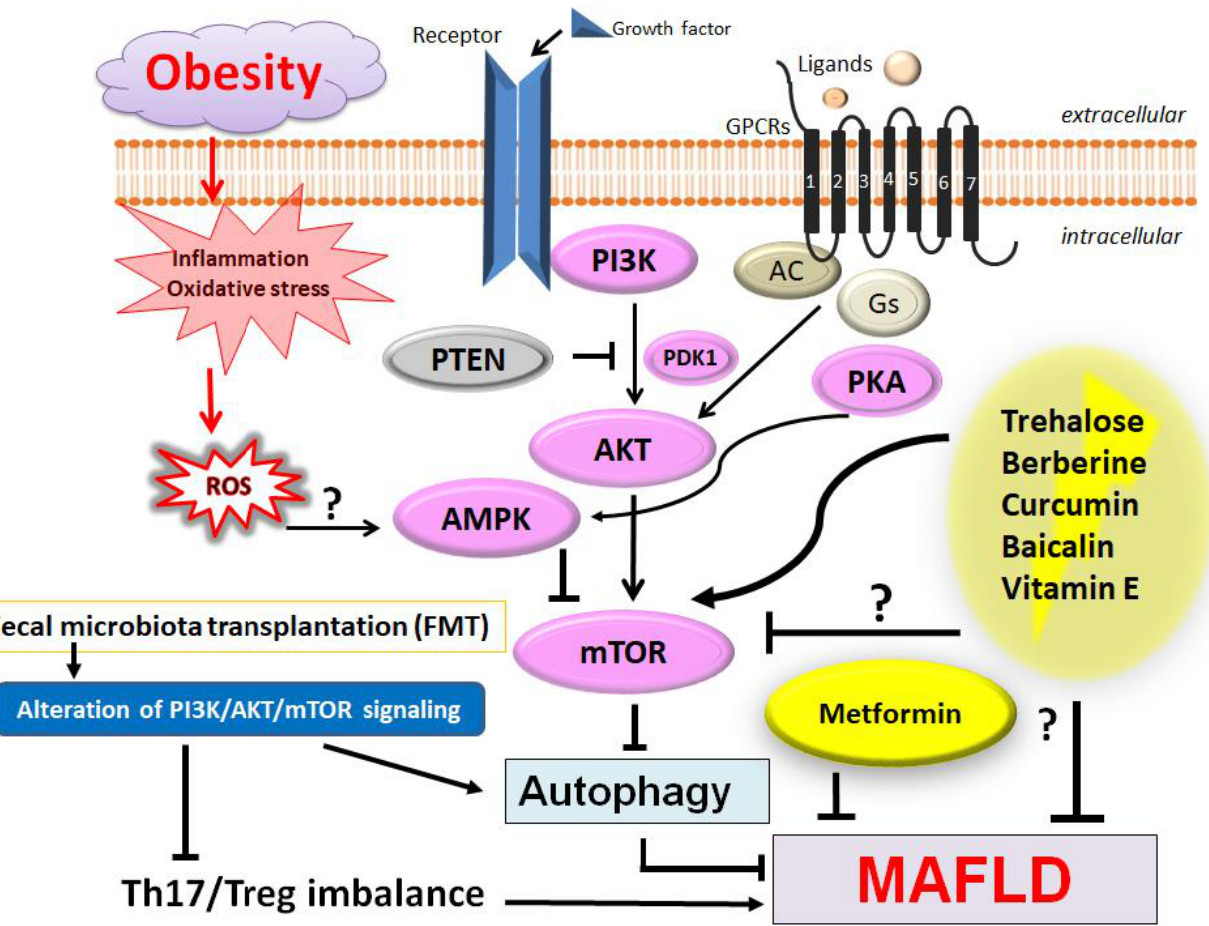
Figure 2. Several modulator molecules linked to the PI3K/AKT/mTOR signaling pathway have been shown. Example compounds from natural sources known to act on the AMPK/PI3K/AKT/mTOR and/or autophagy-related signaling pathway are also shown. Reactive oxygen species (ROS), inflammation, and/or autophagy might be all involved in the pathogenesis of MAFLD. Fecal microbiota transplantation (FMT) could be effective against the progression of MAFLD. Arrowhead indicates stimulation whereas the hammerhead shows inhibition. Note that several important activities such as cytokine induction or anti-inflammatory reaction have been omitted for clarity. Abbreviation: AMPK, adenosine monophosphate-activated protein kinase; mTOR, mammalian/mechanistic target of rapamycin; PI3K, phosphoinositide-3 kinase; PKA, protein kinase A; PTEN, phosphatase and tensin homolog deleted on chromosome